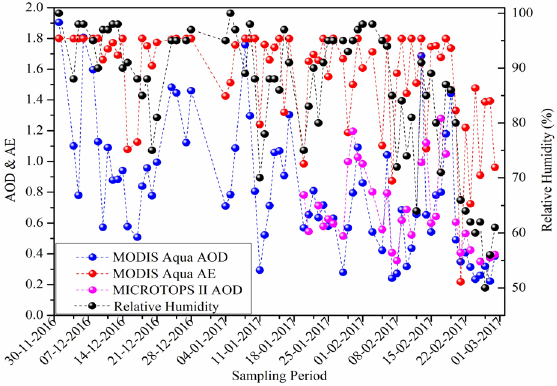
Figure 1: Temporal variation of MICROTOPS II AOD, MODIS Aqua AOD and AE and relative humidity during winter season. The Five days back trajectories using HYSPLIT